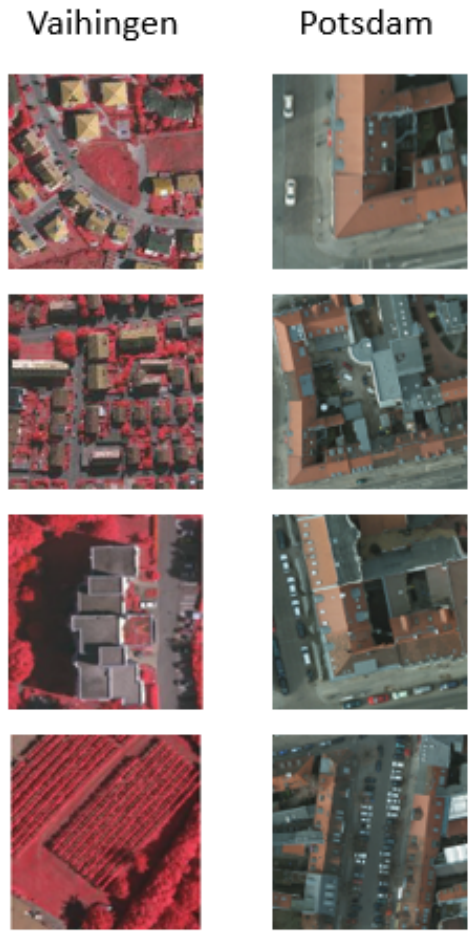
Figure 6. Image samples from Vaihingen and Potsdam ISPRS